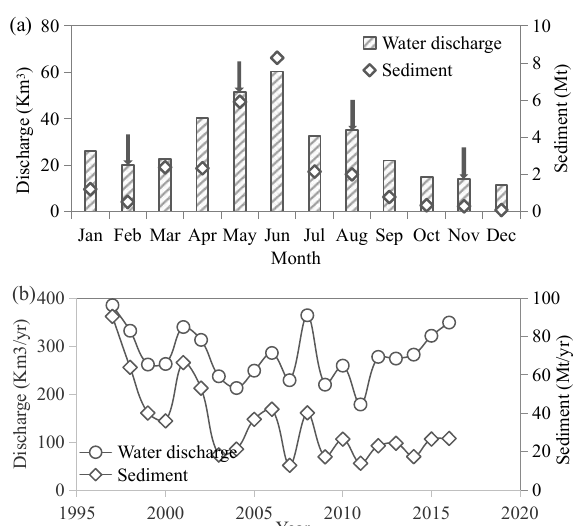
Figure 2. Temporal variations of water and sediment discharge in the Pearl River (sum of Boluo, Shijiao, and Gaoyao hydrological stations). ( a ) Seasonal variation in 2016, ( b ) annual change